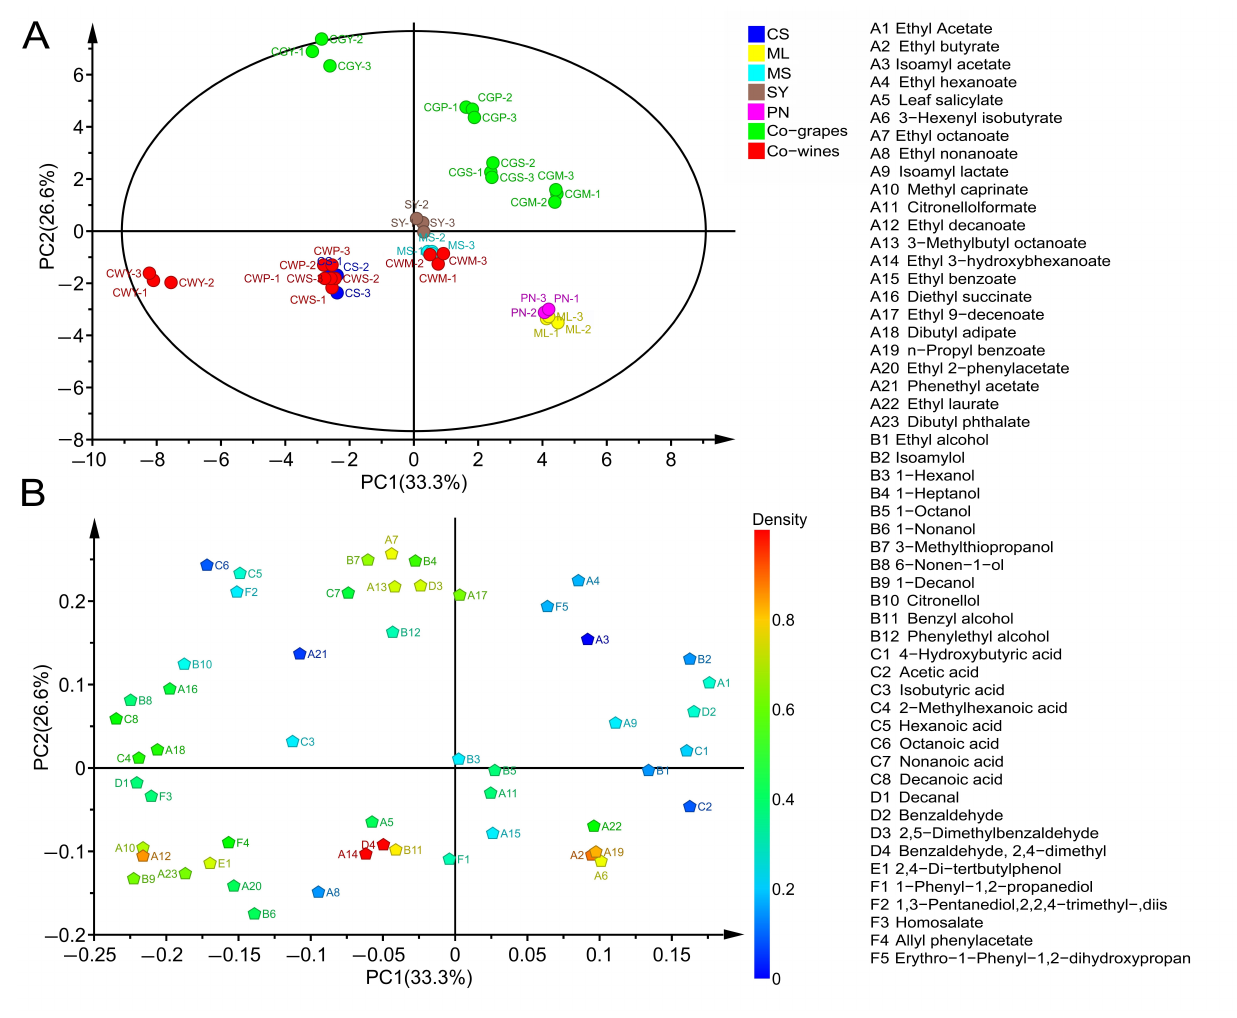
Figure 9. Principal component analysis (PCA) ( A ) and the loadings plot ( B ) of volatile compounds. Figure ( A ) includes all sample names. The serial numbers A1 to F5 in the chart on the right delegate the volatile compound names in Figure ( B ),